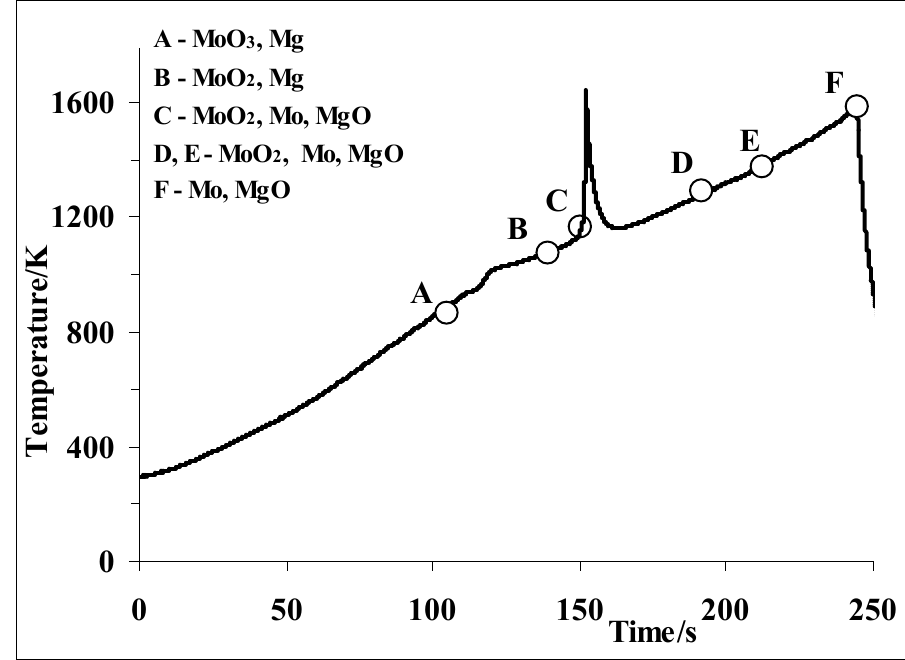
Figure 7. The heating thermogram of the MoO 3 + 1.5Mg + C mixture with the XRD analysis results of the quenched samples at different characteristic temperatures, A—T = 923, B—1073, C—1153, D—1273, E—1423, F—1573 K, V h = 300 K min − 1 .